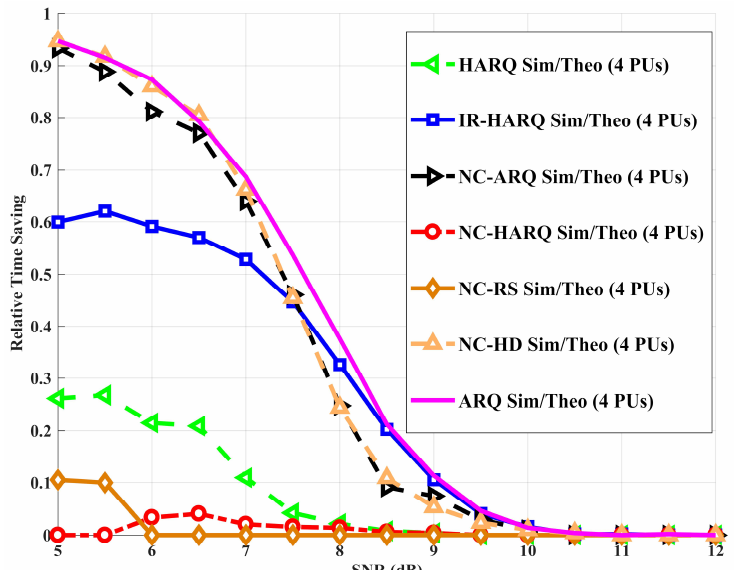
Figure 4. AC2NC relative bandwidth saving.